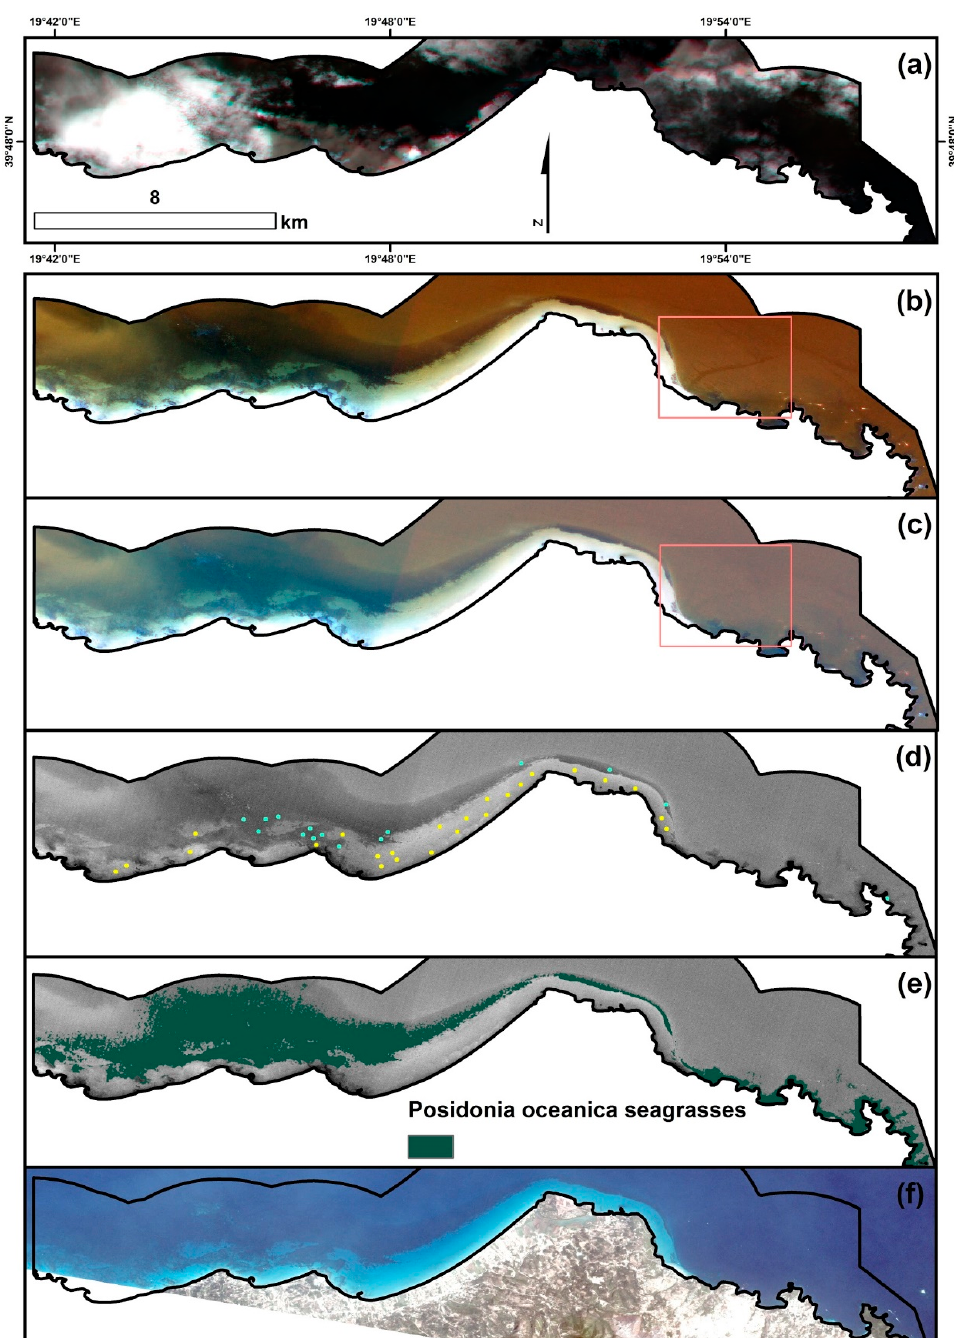
Figure 4. Successive stages of the developed workflow through the resulting false-color (b1-b2-b3) Sentinel-2 composites. ( a ) Initial S2, ( b ) cloud- and atmospherically-corrected, ( c ) sunglint-corrected, ( d ) depth invariant index b2-b3, ( e ) support vector machines-based classified product draped over the b2-b3 depth invariant index layer, ( f ) PlanetScope surface reflectance product (as imaged by Planet’s Doves) in natural color for high resolution reference (3 m) (ID: 20170828_084352_100e/20170828_084352_100e_3B_AnalyticMS_SR). The pink squares indicate sunglint presence in ( b ) and its correction in ( c ). The green and yellow polygons show employed seagrass and sand pixels in the machine learning classification. All panels are in GCS WGS84 World Geodetic System.